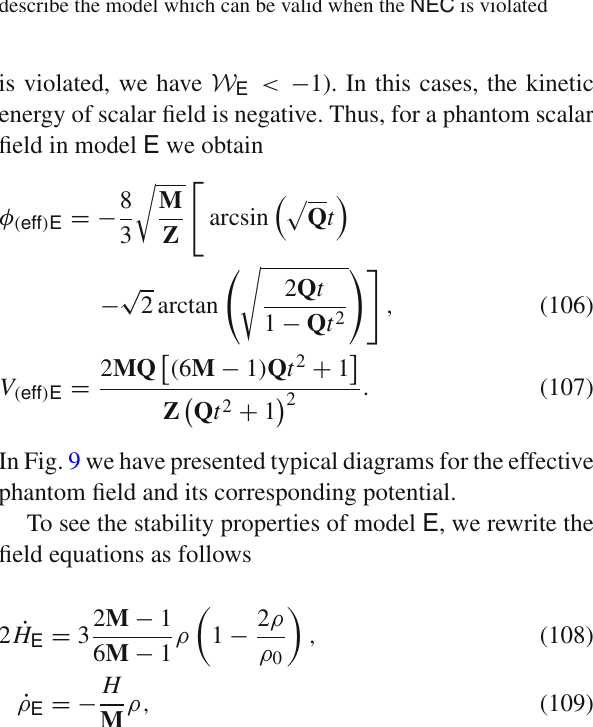
Fig. 9 Theeffectivephantomscalarfieldandthecorrespondingpoten- tialforthemodel E .Asbefore,thehorizontalaxisshowsthetimevalues. In the model E , the NEC is violated only near the bounce (within the √ √ Q < t < 1 / Q ) in contrast to the other discussed mod- period − 1 / els. A phantom scalar field representation can be used to equivalently describe the model which can be valid when the NEC is